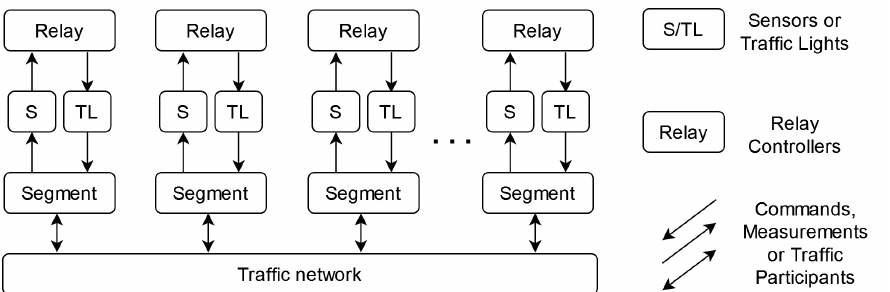
Figure 1. Structure of the decentralized control system for the traffic network.